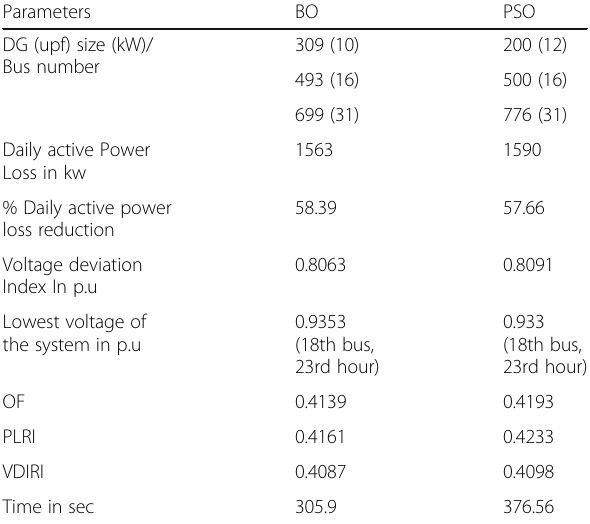
Table 4 Result analysis for optimal allocation of DGs at upf